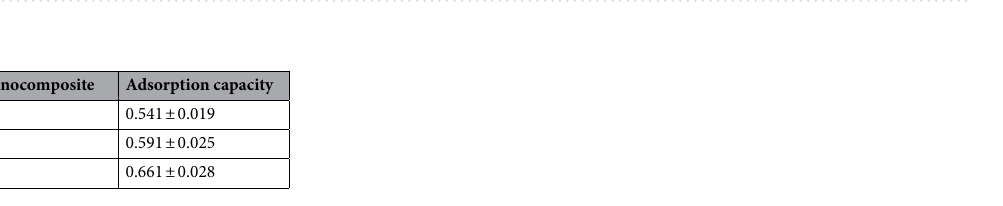
Table 4. Adsorption capacity of synthesized magnetic